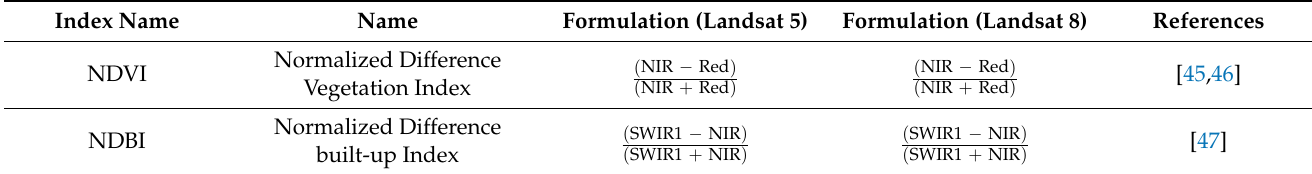
Table 2. NDBI and NDVI indices for 2000, 2005, 2010, and